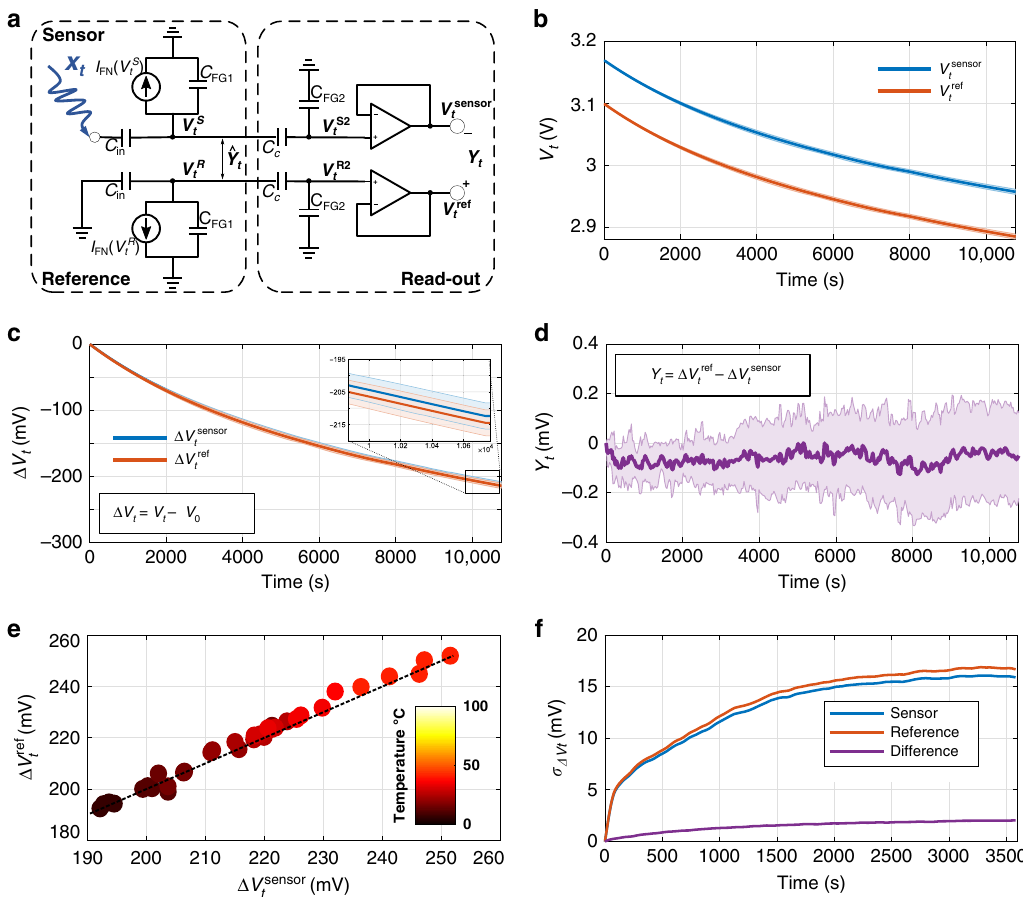
Fig. 2 Differential FN sensor-data-logging device and its measured response. a Equivalent circuit of the differential FN device coupled to the read-out circuitry. b Sensor and reference output voltages measured across nine trials after the device is initialized. c Change in sensor and reference values compared to the initial value V 0 as Δ V t = V t − V 0 . Shaded region in inset shows ±1 standard deviation. d Measured desynchronization between the sensing and reference devices, with bold line showing mean across trials. e Synchronization measured across a range of operating temperatures (5 – 40°). The gradient (dark red to yellow) denotes an increase in operating temperature. f Standard deviation measured for the sensor, reference and the difference over 36 trials and across range of operating